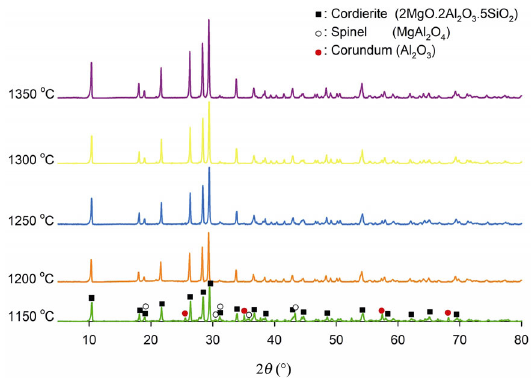
Fig. 8 XRD analysis of the samples sintered at different